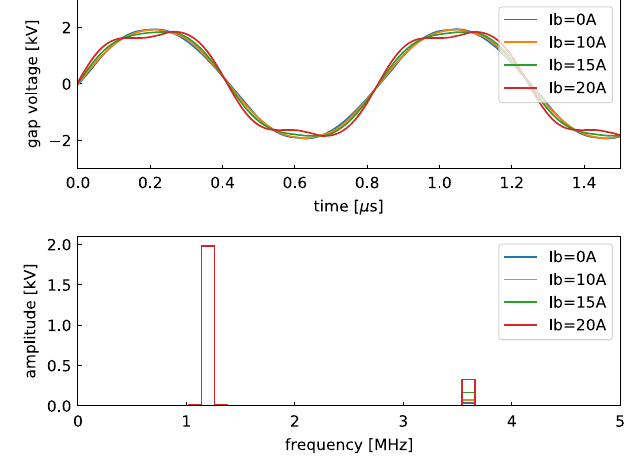
FIG. 4. (Top) Gap voltage waveforms with the compensation signal of the fundamental accelerating harmonic and (bottom) the frequency spectrum of the gap